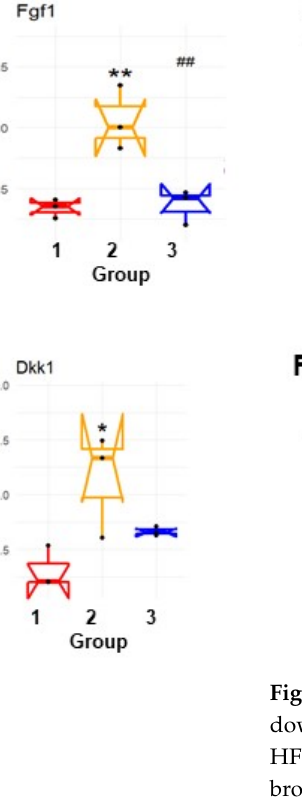
Figure 10. Changes in gene expression in the adipose tissue of shNOV-treated mice (NOV knock- down). RNA-array-analyses changes in the correlation coefficients of gene expression in lean, HFD, and Lnv-adipo-shNOV (HFD) groups. Shown is the mRNA expression (PCR array) of Angiopoietin 2 (Angpt2) ( A ), adiponectin (Adipoq) ( B ), Bone Morphogenetic Protein 2 (BMP2) ( C ), Bone Morpho- genetic Protein 4 (BMP4) ( D ), Bone Morphogenetic Protein 7 (BMP7) ( E ), Adipogenin (Adig) ( F ), beta-2-adrenergic receptor (Adrb2) ( G ), Axin ( H ), Angiotensinogen (Agt) ( I ), Cyclin D1 (Ccnd1) ( J ), Cyclin-Dependent Kinase 4 (Cdk4) ( K ), and Cyclin-Dependent Kinase Inhibitor 1A (Cdkn1a) ( L ) in the adipose tissue of lean, high-fat diet (HFD), and shNOV-treated mice. Data are expressed as means ± SE; ( n = 5); * p < 0.05, ** p < 0.005 versus lean; # p < 0.05, ## p < 0.005 versus HFD.